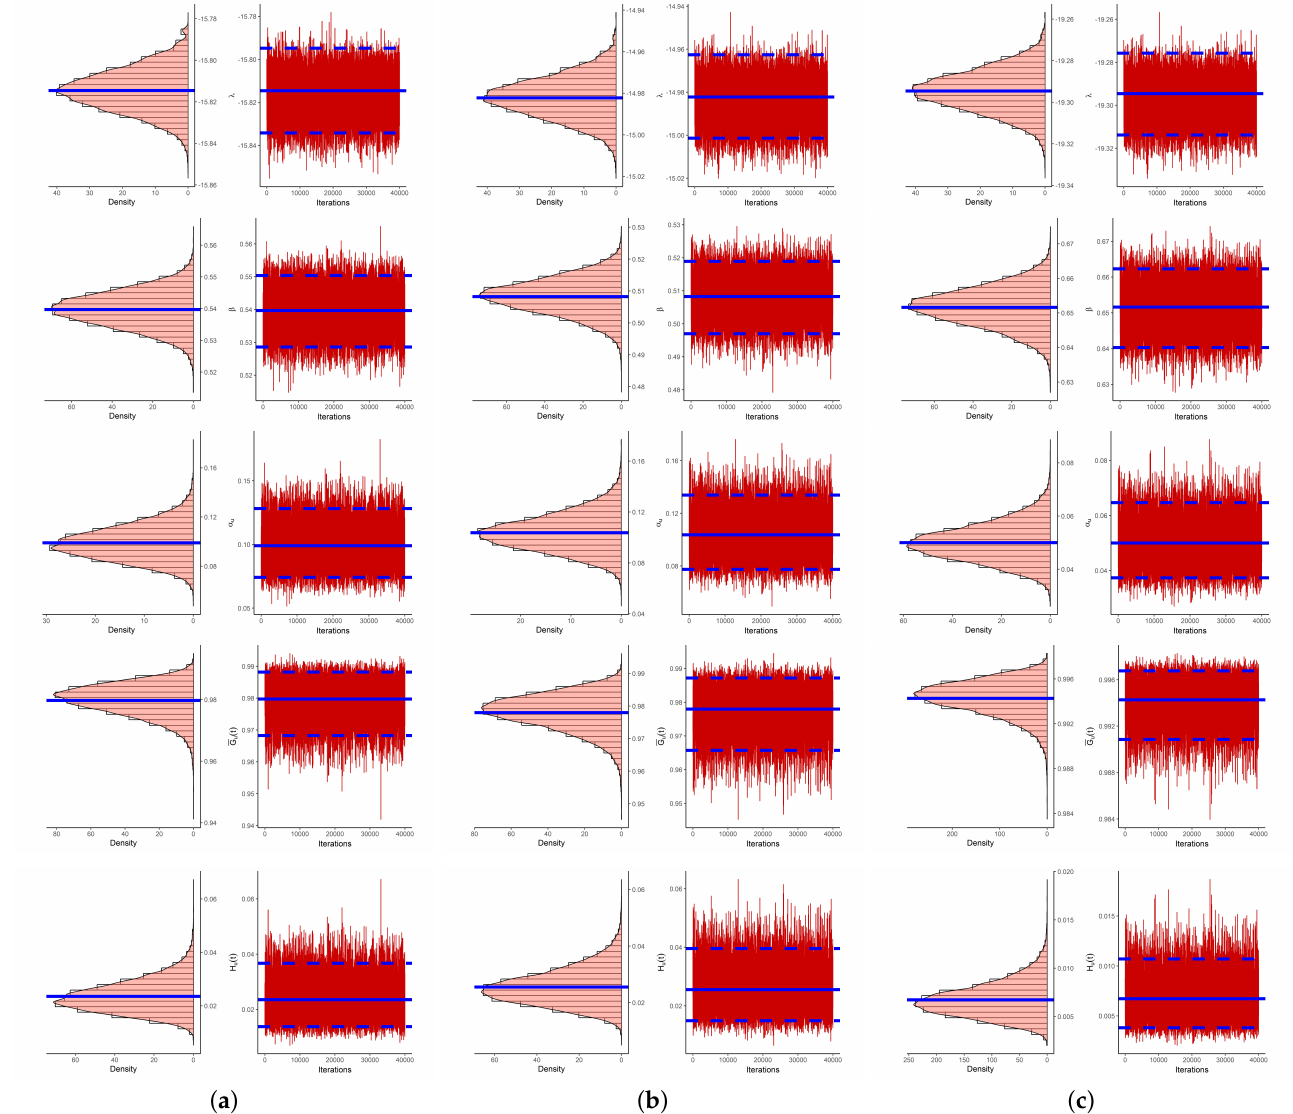
Figure 8. Density ( left ) and trace ( right ) plot of λ , β , α u , G u ( t ) and H u ( t ) from OBT data. ( a ) Sample 1; ( b ) Sample 2; ( c ) Sample